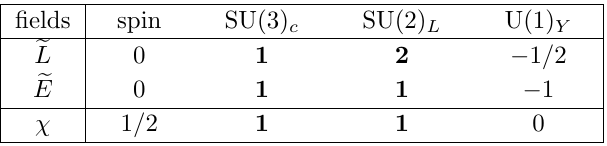
Table 3 . Matter content in the fermion DM